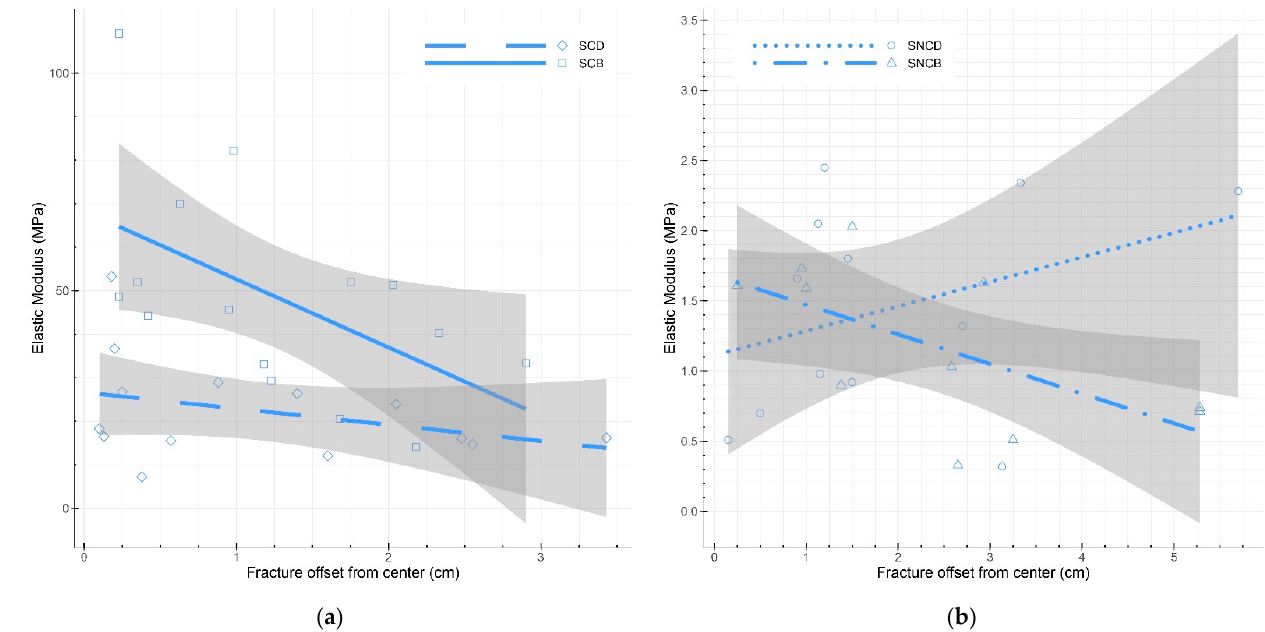
Figure 8. This figure shows elastic moduli calculated from the ASTM D1037 formula in relation to the distance between the fracture and the center of the specimen, grown from Coprinus comatus : ( a ) compacted samples; ( b ) uncompacted samples. For the compacted and baked non-compacted samples, elastic modulus decreases as fracture happens further away from the ideal scenario. Acronyms for each sample are labeled in Table 1.